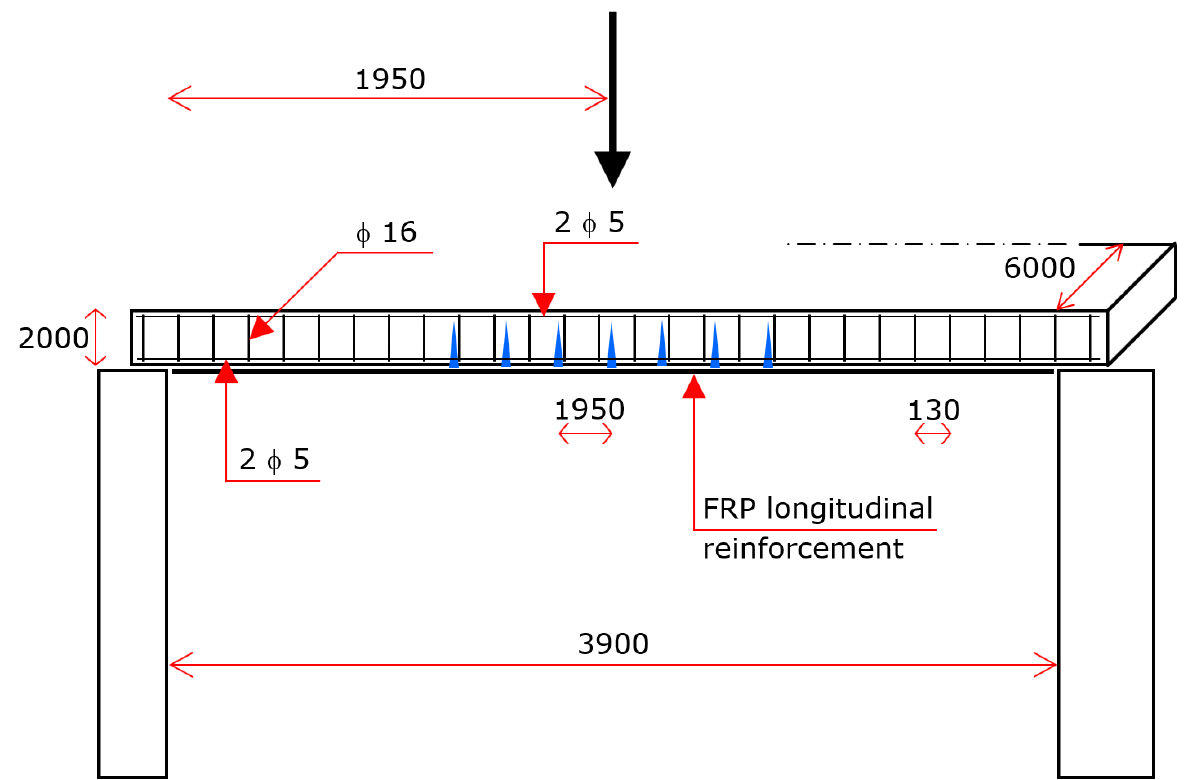
Figure 8. Diagram of the four identical RC beams that were tested. The figure shows the span, the dimensions of the cross-section, the longitudinal steel bars, the steel stirrups, and the externally bonded flexural reinforcement. The symbol φ denotes the diameter of a steel bars and a stirrup. Vertical cracks were produced around the midspan with a specific loading. The diagram also shows those cracks and their spacing. A vertical force (shown in the diagram) was applied to the midspan of each beam and was increased to failure.